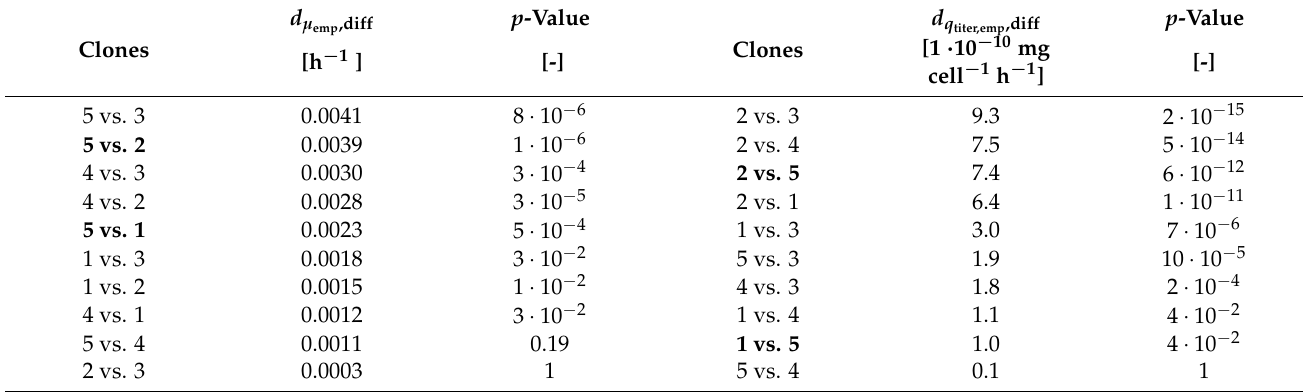
Table 4. Results of the test regarding differences in means: differences concerning growth rate ( d µ p -value) and concerning production rate ( d q